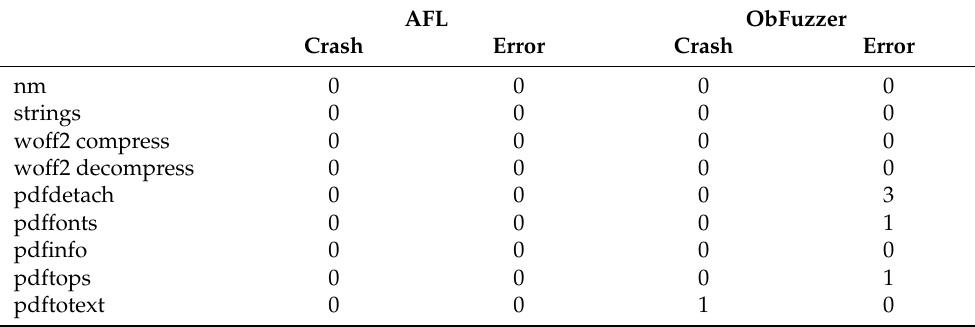
Table 2. The unique vulnerabilities and errors ObFuzzer found in AFL and